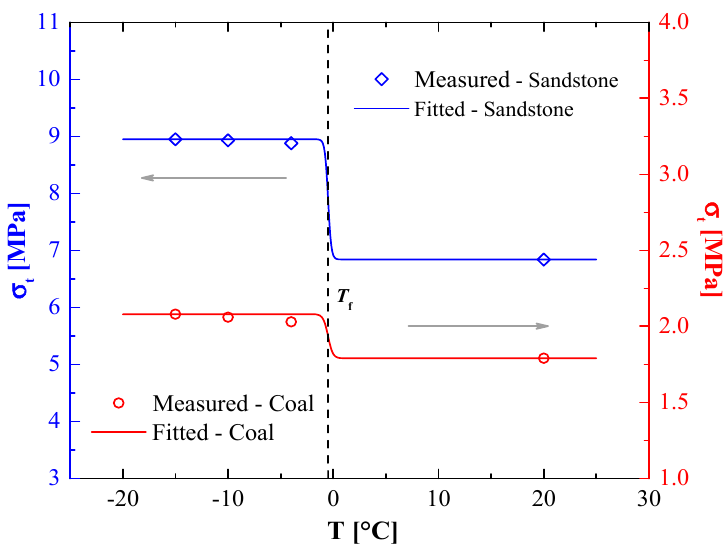
Figure 2. Tensile strengths of sandstones and coal samples as a temperature function. Table 2. Theory parameters (Equation (3)) for tensile tests.